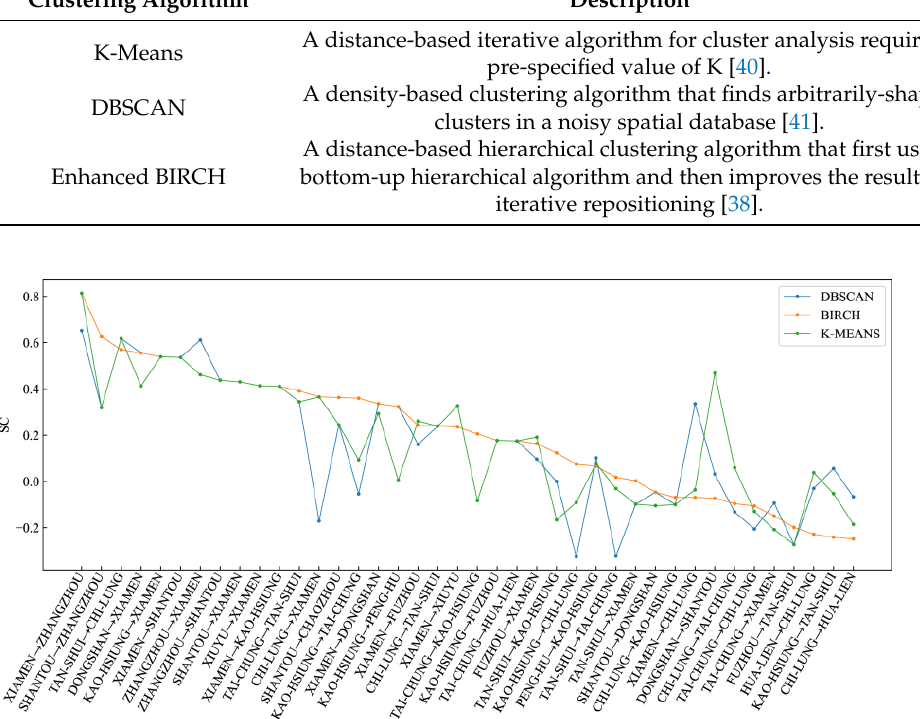
Figure 14. Comparison of DBI evaluation indices for different clustering algorithms. Figure 15. Comparison of CCPM evaluation indices for different clustering algorithms. Taking the ship trajectories with big differences in spatial distribution from Kaohsiung Port to Xiamen Port as an example, the three clustering algorithms (K-Means, DBSCAN, and BIRCH) were used to cluster the ship trajectories, and the evaluation re- sults are shown in Figure 16a – c. It can be seen that all three clustering algorithms gave similar and quality clustering results and the fluctuations and peaks of each evaluation index were obvious, which demonstrates that for ship trajectories with big differences in spatial distribution, all three clustering methods are competent.